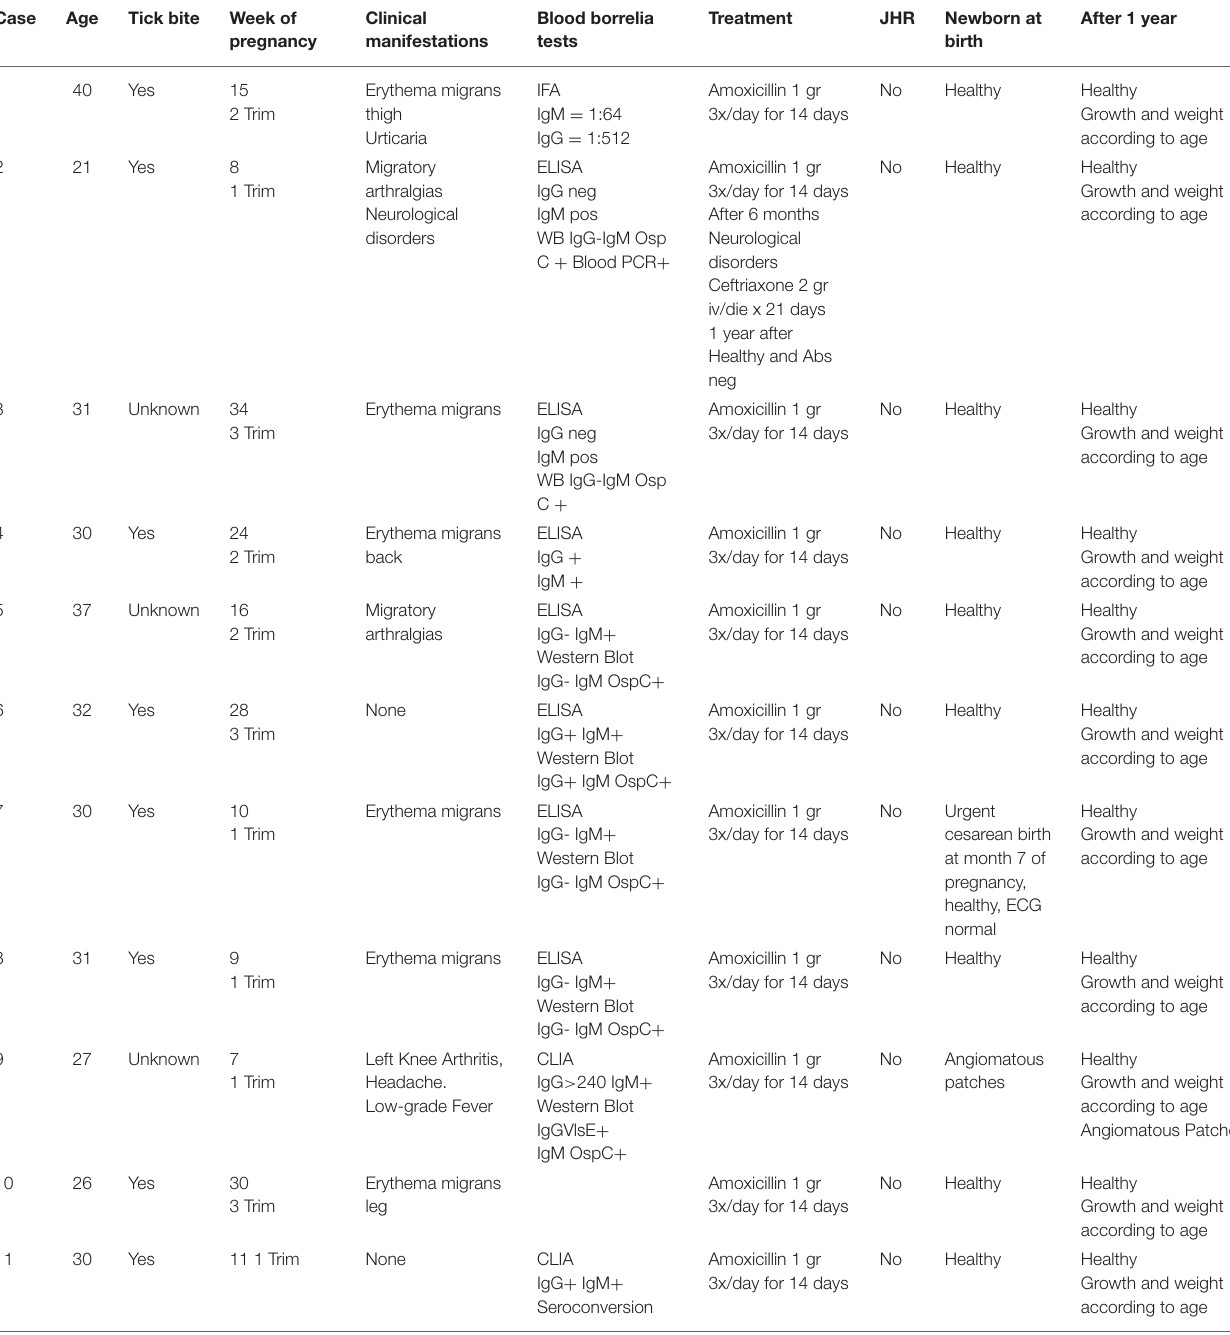
TABLE 2 | Cases observed from 2008 to